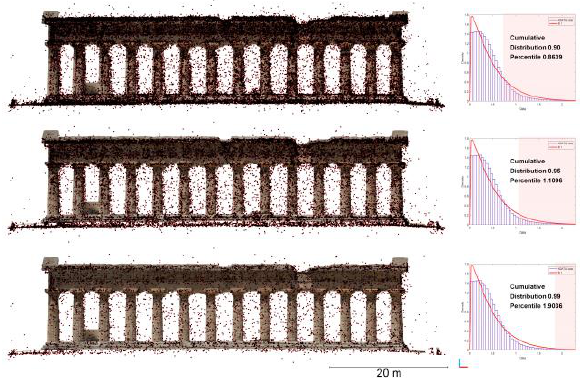
Figure 5 . Filtering of reprojection error parameter on values above the lower cumulative